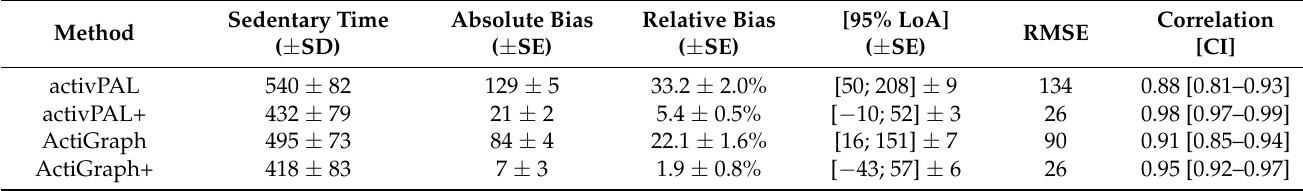
Table 1. Average sedentary time per day measured with each single-sensor method compared to